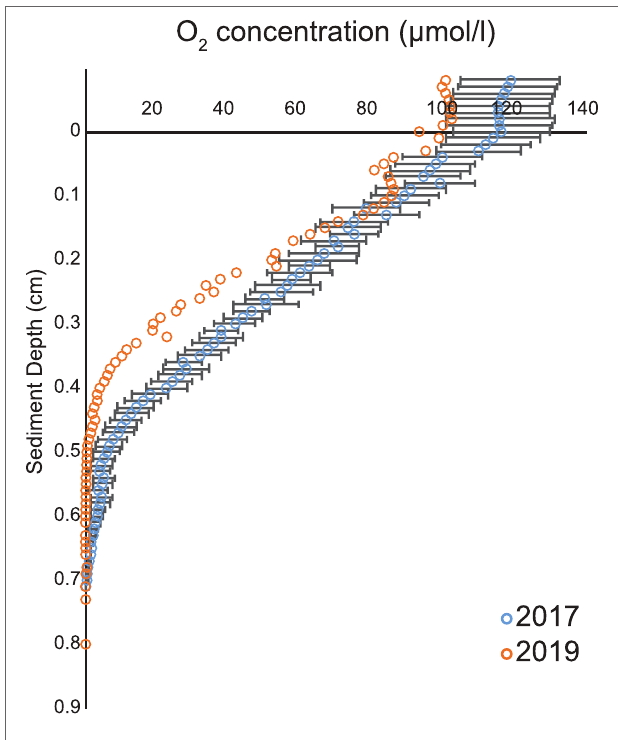
FIGURE 1 | Oxygen profiles from years 2017 and 2019. Average (blue open circles) and SEM (black line) of five O 2 profiles during 2017 and 2019 cruises (orange open